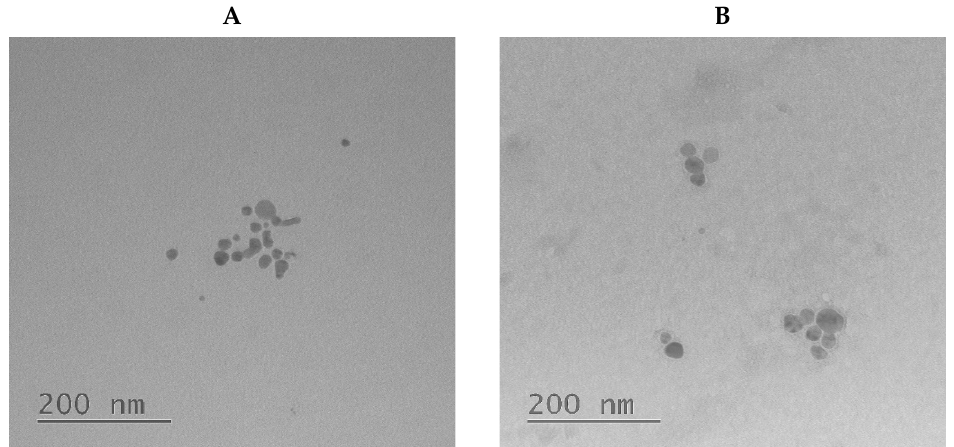
Figure 4. TEM images of PGlu@Ag nanoparticles without staining ( A ) and with uranyl acetate staining ( B ).